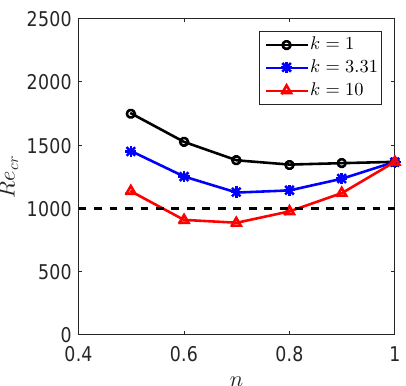
Figure 7. The critical Reynolds number for different k values with different n